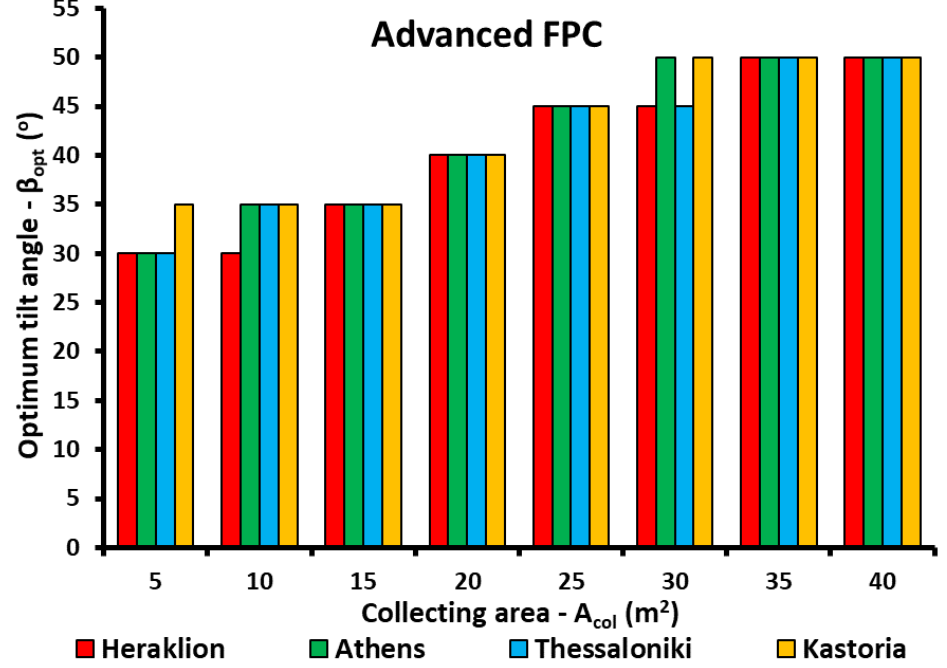
Figure 14. Optimum tilt angles for maximizing the solar coverage with advanced FPC for the examined locations.